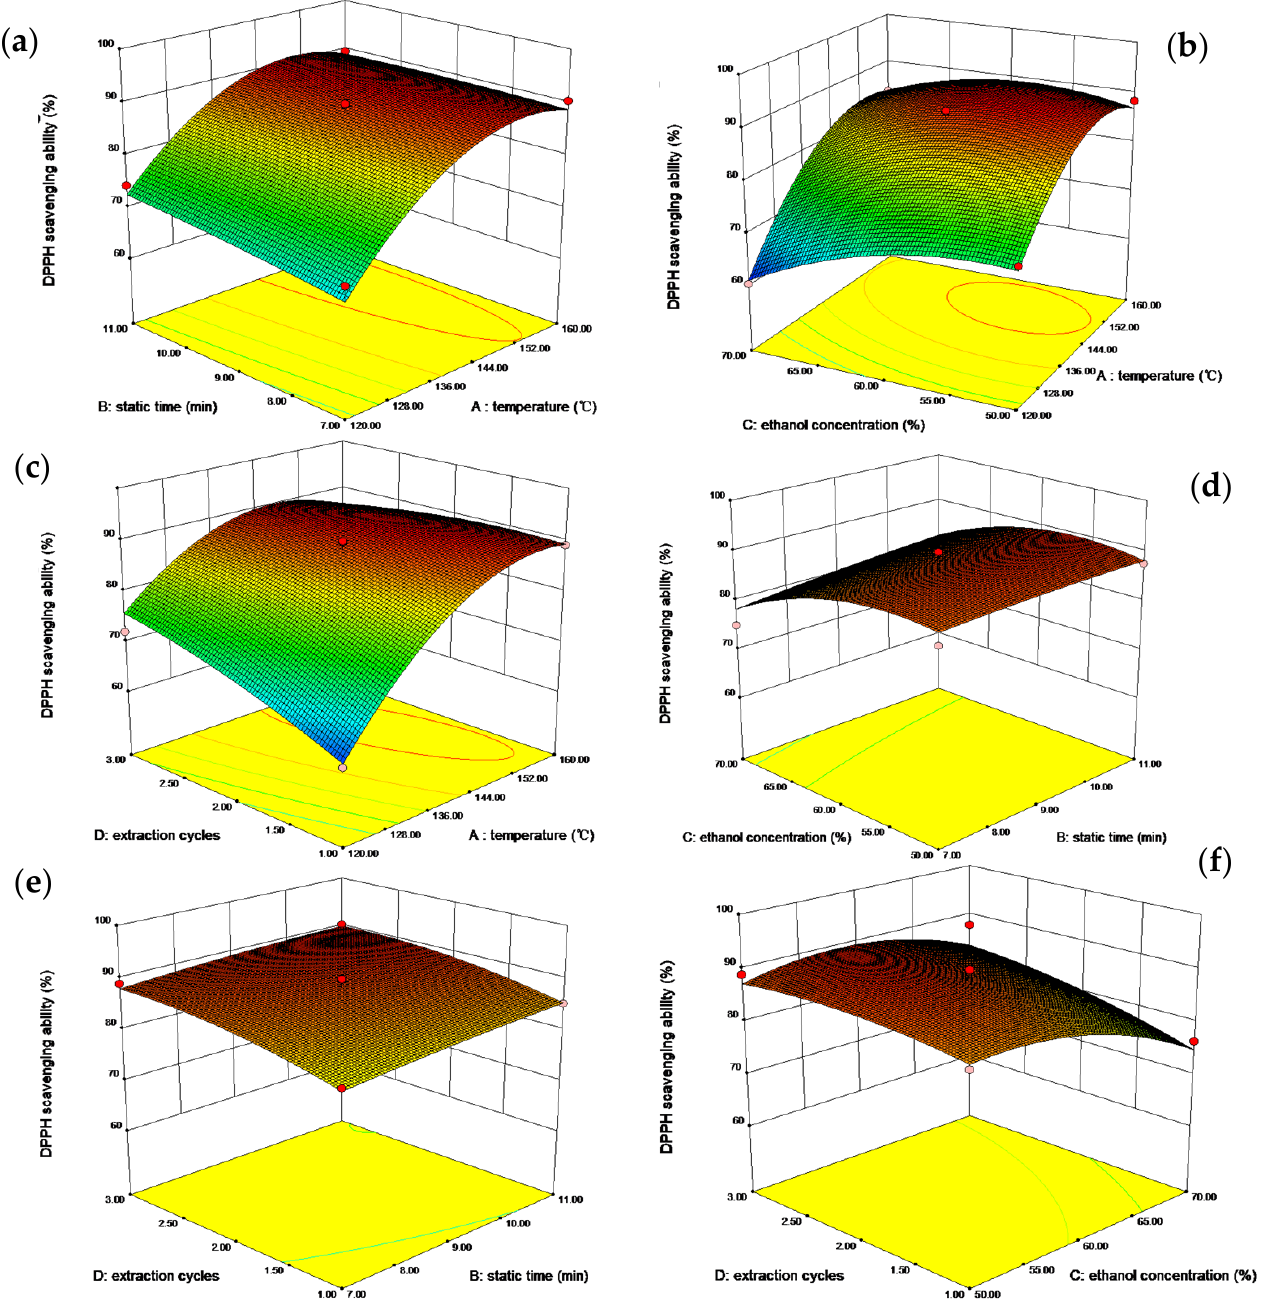
Figure 1. Response surface plots showing effects of the ASE parameters on the antioxidants’ extraction from Gardeniae fructus. The model was constructed by varying two variables within the experimental range under investigation and holding the other two variables at the “0” level: ( a ) varing temperature and static time; ( b ) varing temperature and ethanol concentration; ( c ) varing temperature and extraction cycles; ( d ) varing static time and ethanol concentration; ( e ) varing static time and extraction cycles; ( f ) varing ethanol concentration and extraction cycles.